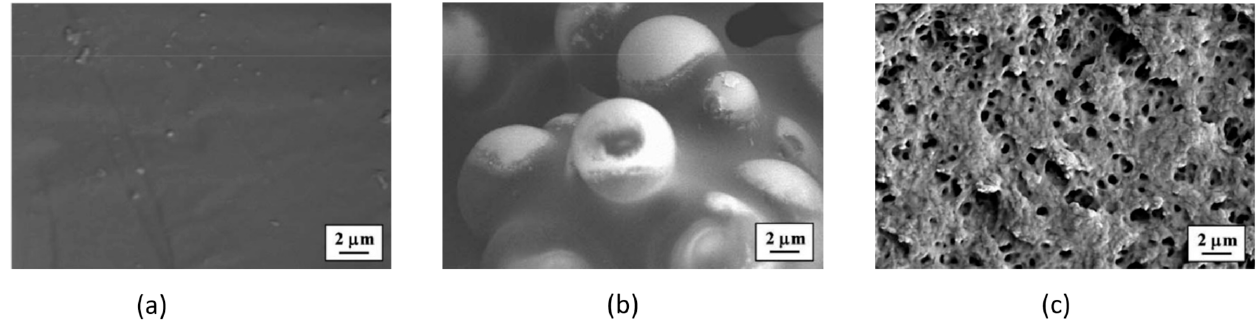
Figure 23. Microstructure for EPON 828/PACM-based multifunctional polymers at 65% of electrolyte content from Gienger et al. [83]. ( a ) 1 M LiTFSI in PC. ( b ) 1 M LiTFSI in PEG. ( c ) Segregated 1M LiTFSI in PC.